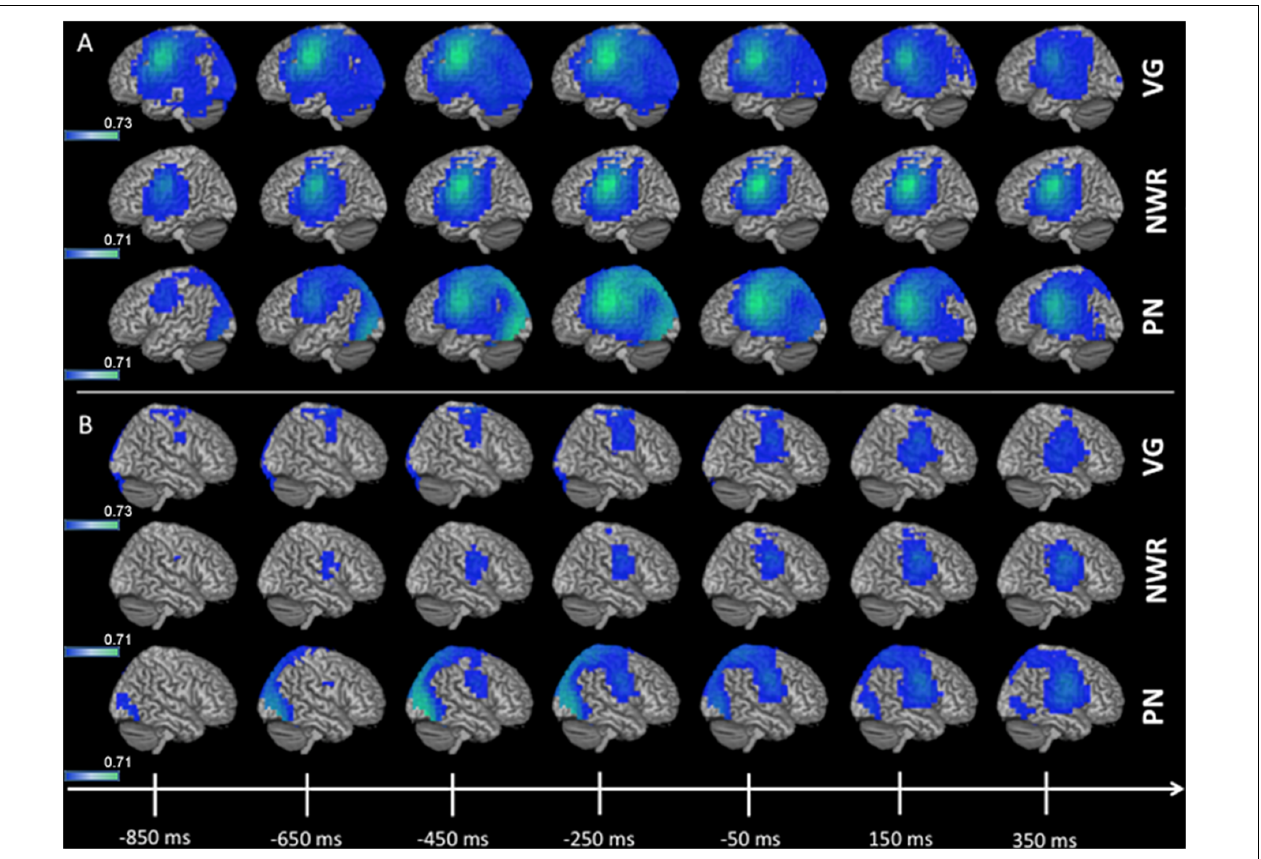
FIGURE 3 | 3D overlay of average changes (reduction of beta power, in blue) during response preparation (response-locked) for the verb generation (VG), non-word repetition (NWR), and picture naming (PN) tasks in the strong left group. Similar to stimulus encoding, during response preparation strong activation over temporal, parietal and frontal regions are observable in the left hemisphere (A) and to a lesser extent in the right hemisphere (B) . Conventions as in Figure 2 .